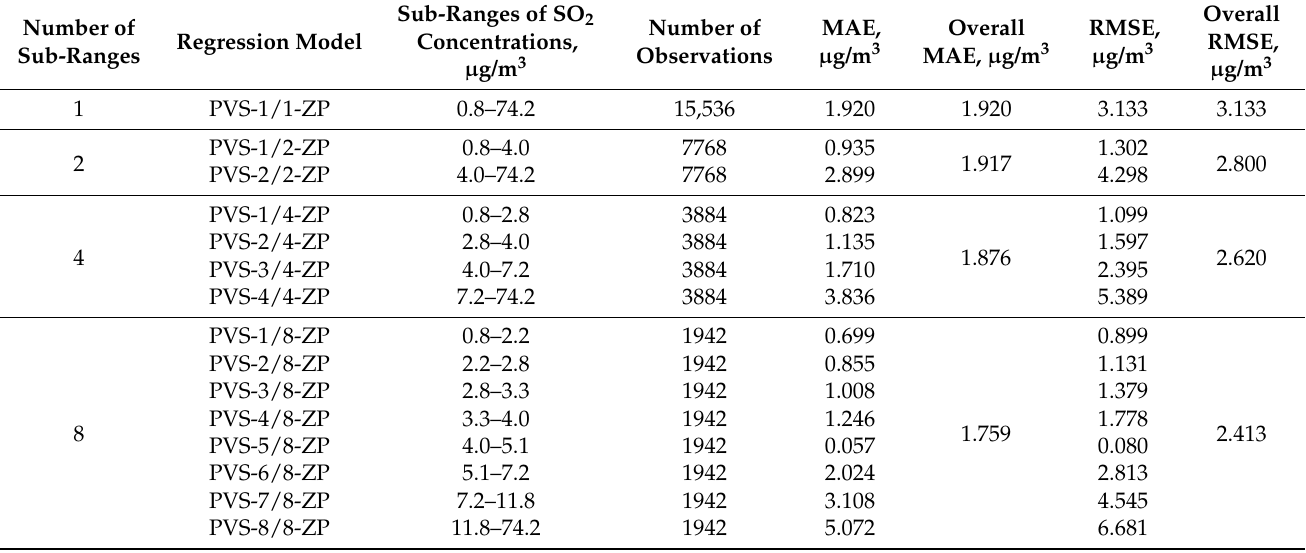
Table 16. Values of approximation errors of SO 2 concentrations in PVS models, Złoty Potok